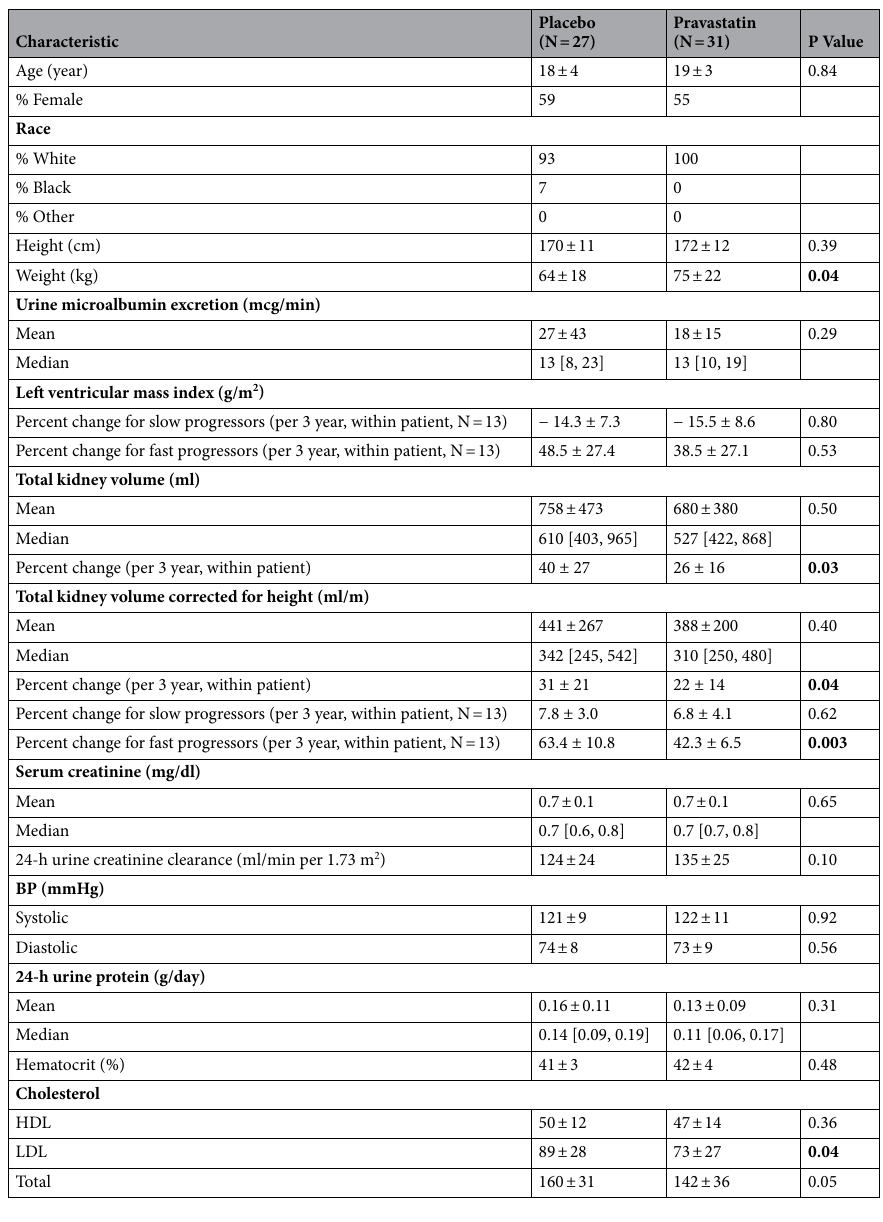
Table 2. Characteristics of the patients at the final visit (N = 58). Samples from the same patients were available at the baseline and the 36-month time points (as reported in 12 ). Values are the mean ± SD or median [25th percentile, 75th percentile]. P < 0.05 considered significant (bolded).